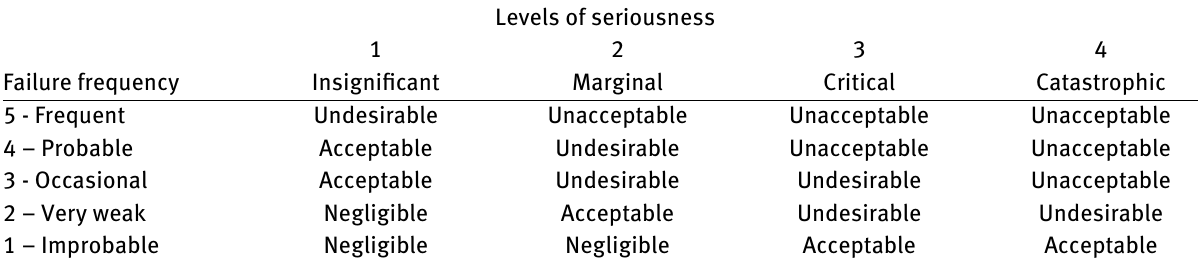
Table 1: Risk acceptability assessment